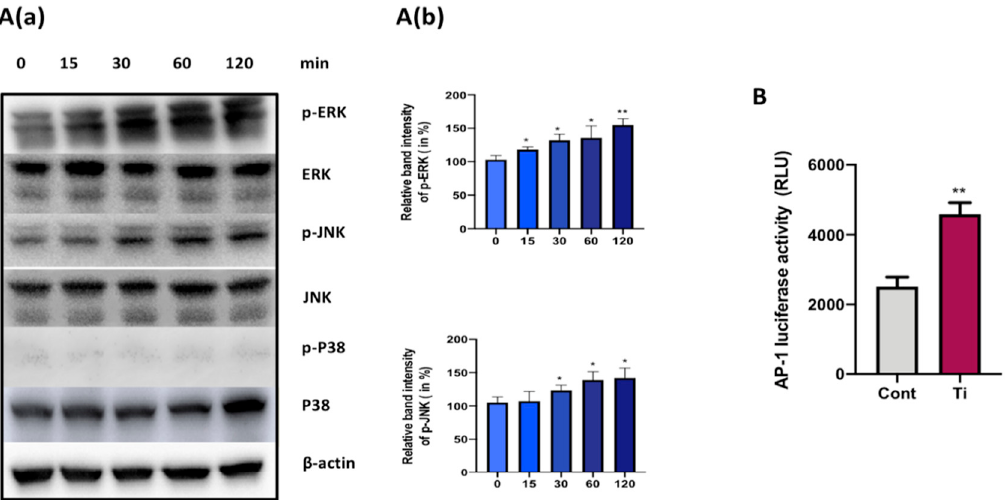
Figure 3. E ff ect of Ti particle on the activation of MAPKs in SW982 cells. ( A ( a )) Representative Western blots showing protein levels of total and phosphorylated forms of extracellular signal-regulated kinase (ERK) and c-Jun N-terminal kinase (JNK) and P38 mitogen-activated protein kinases (MAPKs) after treatment with Ti particles (cell-to-particle ratio of 1:100) of SW982 cells for 15, 30, 60, and 120 min. Here, β -actin was taken as control. ( A ( b )) Fusion FX software was utilized for quantitative densitometric analysis of the proteins. ( B ) AP1-luc reporter plasmids were transfected to SW982 cells for 24 h and luciferase activity was analyzed. Renilla luciferase activity was used for normalization. The results are demonstrated as means ± SDs of three independent experiments. In the graphical representations, * p < 0.05 and ** p < 0.01 indicate significant differences from the control group.